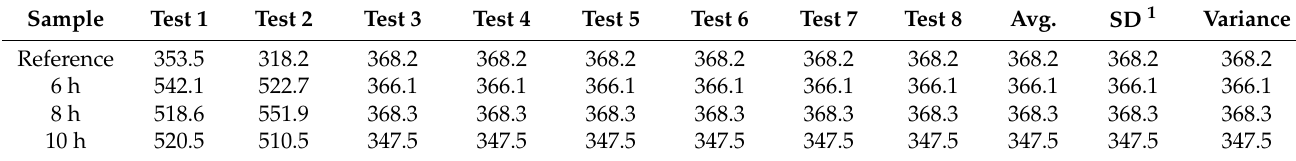
Table 3. Vickers microhardness measurements in HV0.1.